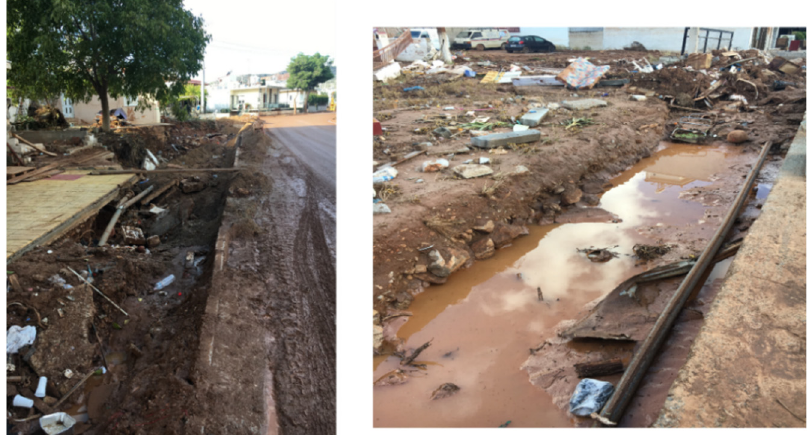
Figure 6. Uncertainty issues at the observation points: the finally selected values for the observed maximum depths are 0.80 m (left), 1.01 m (right).